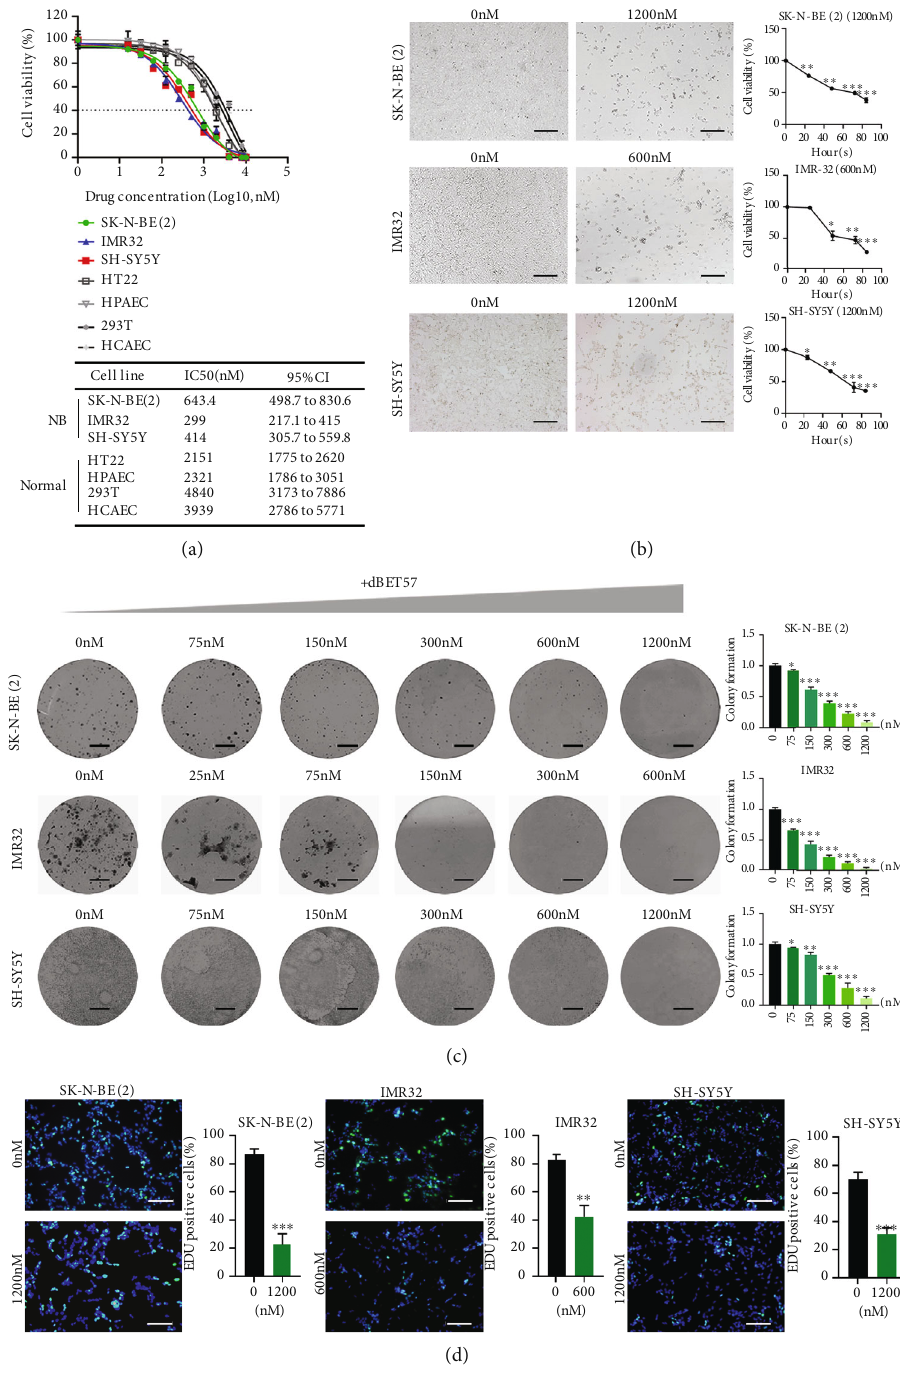
Figure 1: dBET57 impaired the proliferation of NB cells. (a) NB cells and 4 normal cells were treated with gradient concentration of dBET57 for 72h to analyze the cell viability curve and calculate the value of semi-inhibitory concentration. (b) Morphological changes and cell viability curves (with time as reference) of NB cells treated with dBET57 gradient concentration for 48h. Scale bars: 100 μ m. (c) Colony assay was used to compare the cloning ability of NB cells treated with dBET57 for 48 h. Scale bars: 4mm. (d) EdU experiment proved the proliferation ability of NB cells incubated with dBET57 for 48h. Scale bars: 100 μ m. The experimental groups (di ff erent concentration gradients of dBET57) were compared with the control group (0 nM). ∗ p < 0 : 05 , ∗∗ p < 0 : 01 , and ∗∗∗ p < 0 : 001 ; ns: not signi fi